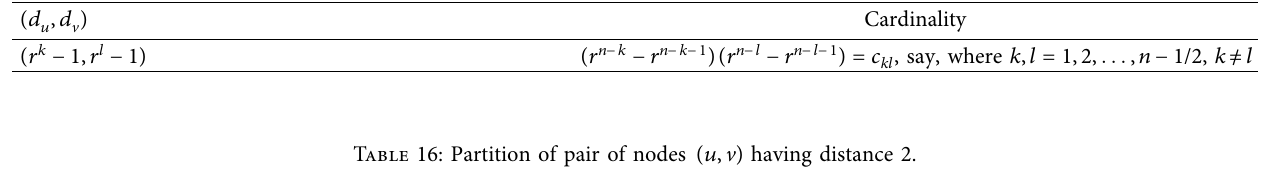
Table 15: Partition of pair of nodes ( u, v ) having distance 2.